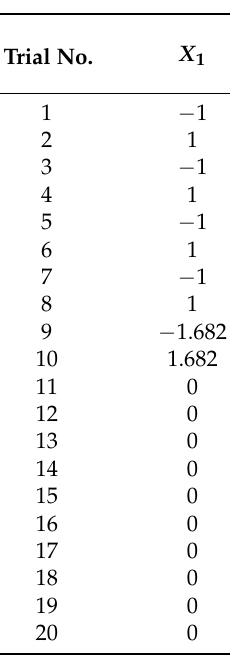
Table 3. Experimental design and results of central composite